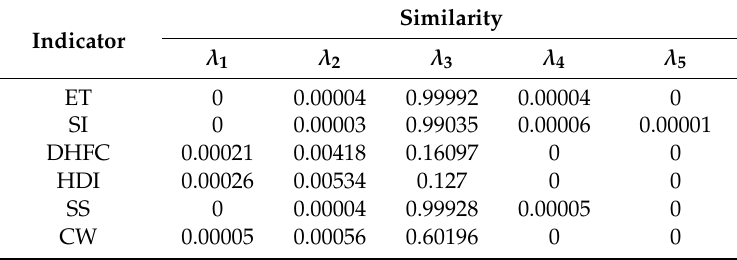
Table 4. Similarities between the cloud model of evaluation indicators and the corresponding standard cloud model.